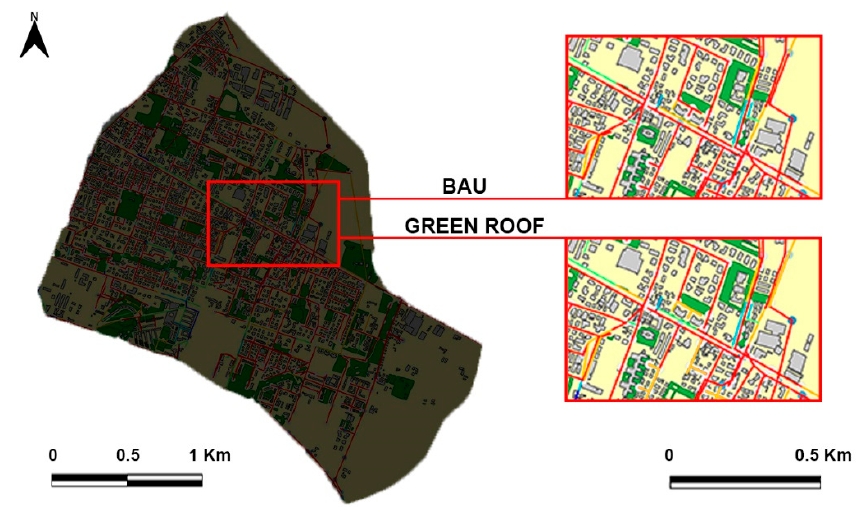
Figure 10. Comparison between “BAU” and “green roof” scenarios.